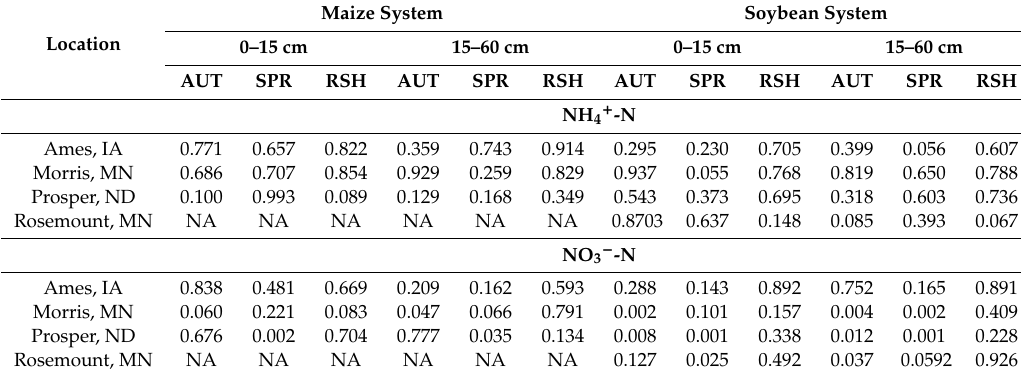
AUT = soil samples taken in autumn; SPR = soil samples taken in spring; RSH = soil sample taken immediately following relayed soybean harvesting; NA = Data not